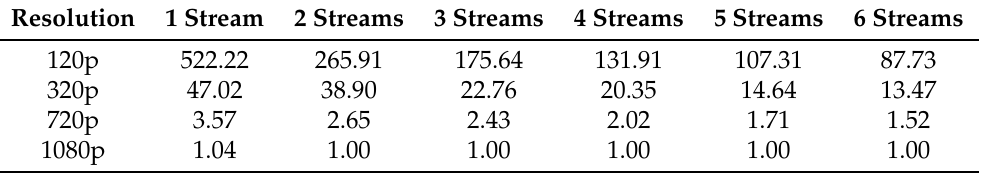
Table 1. Average frames per second of different resolutions at different streamed nodes.